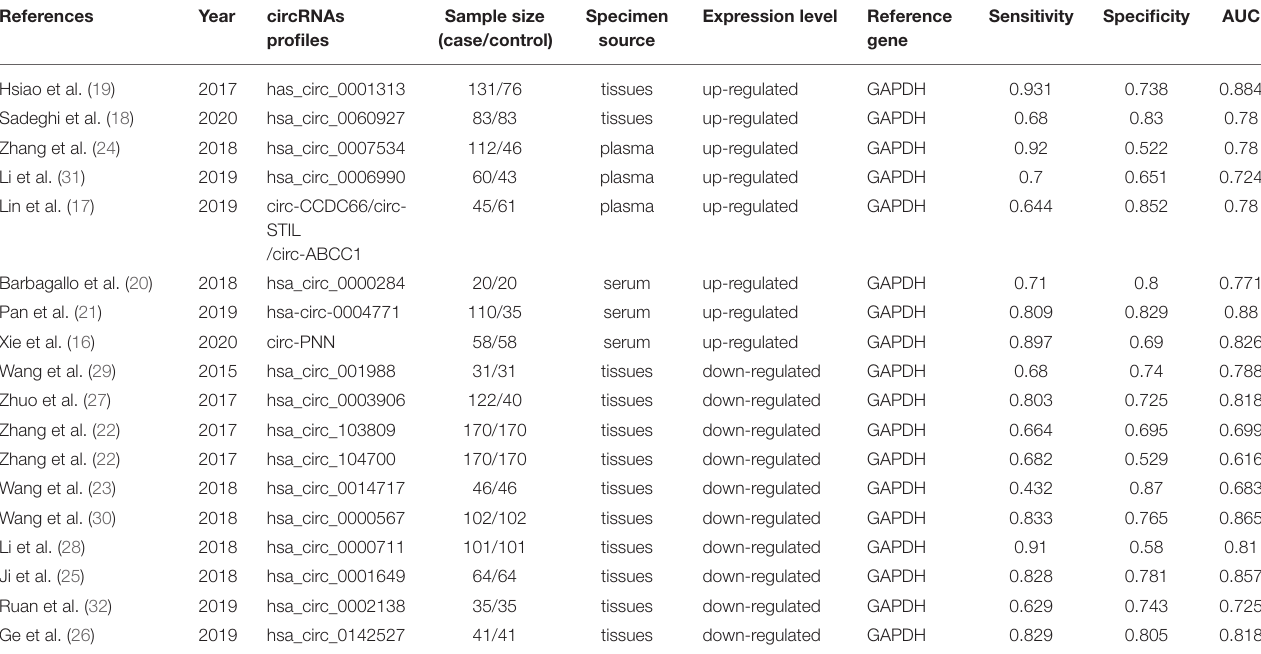
TABLE 1 | Characteristics of the included